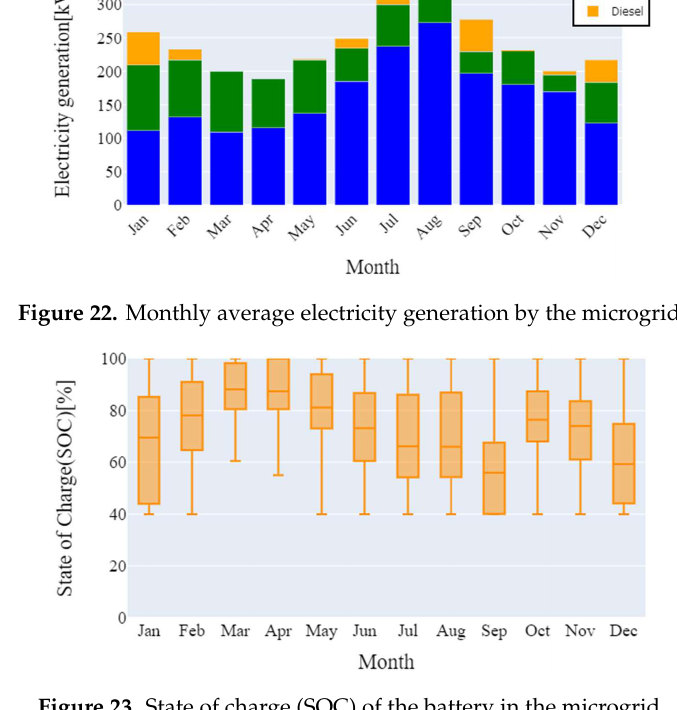
Figure 23. State of charge (SOC) of the battery in the microgrid.